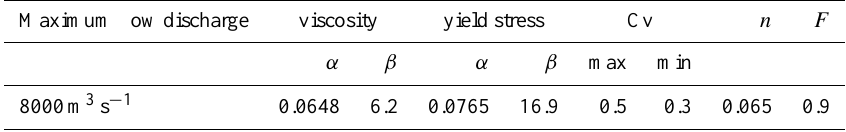
Table 4. Main input parameters used for the FLO-2D